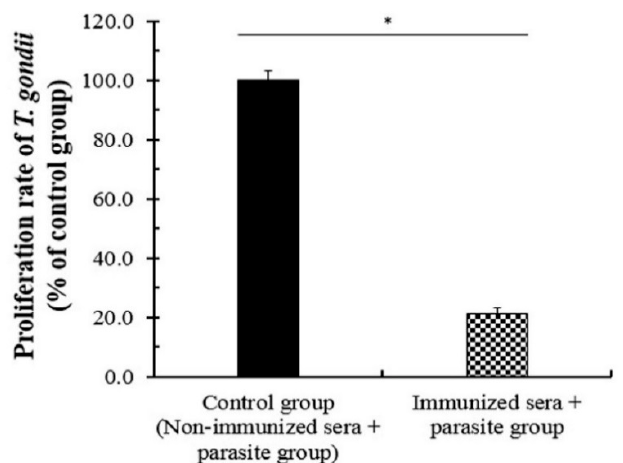
Figure 8. The inhibitory e ff ect of the immunized sera against the proliferation / growth of T. gondii . The sera of mice were collected at 4 weeks after boost immunization. The sera were mixed with T. gondii , which was injected into the abdominal cavity of normal mice. The parasites were collected from the abdominal cavity at 7 days after intraperitoneal (IP) challenge, which was counted. The groups were divided into two groups as follows: the non-immunized sera group infected with T. gondii (control group), and the immunized sera group infected with T. gondii (immunization group).